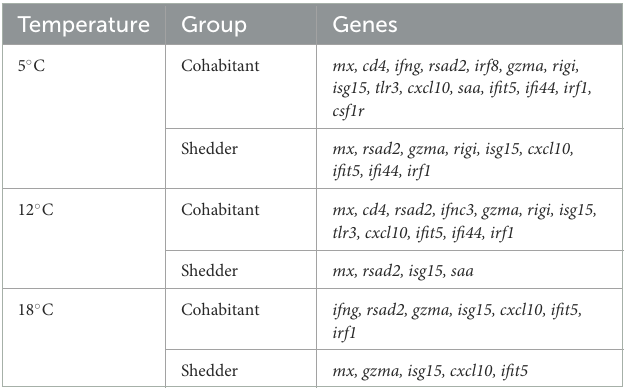
TABLE 5 Genes with positive Pearson’s correlation to the PRV-3 virus load for all time points with p < 0.05.